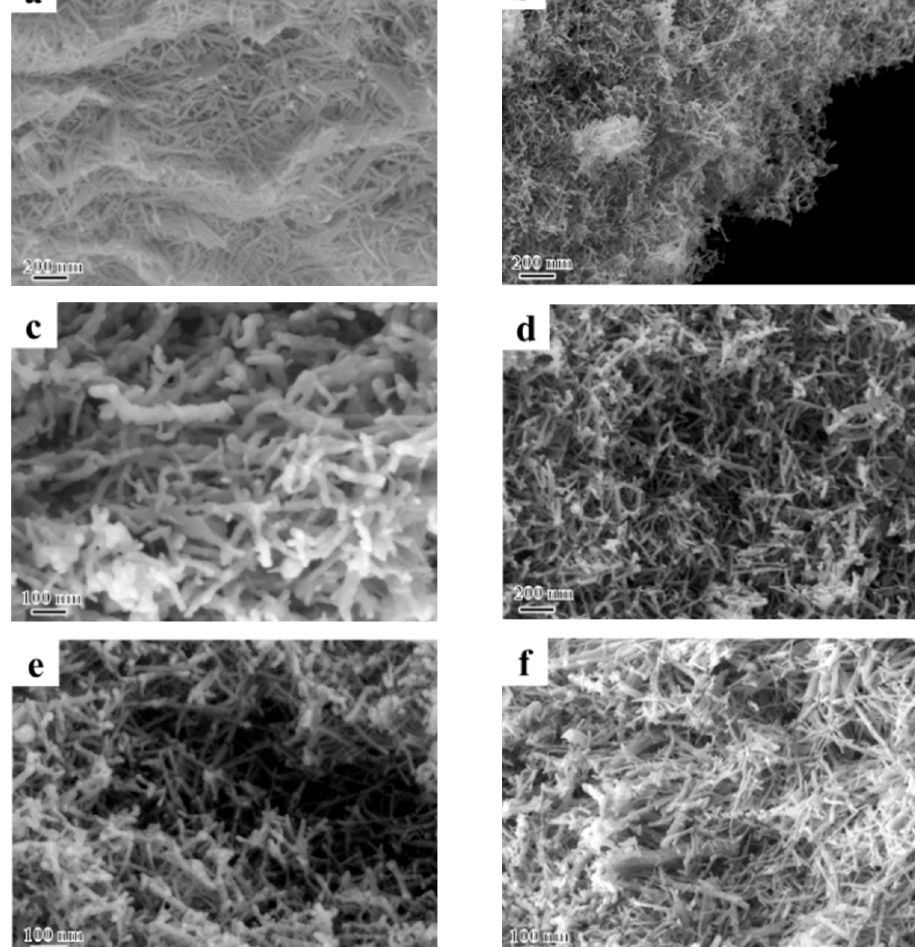
Figure 3. SEM images of the La(OH) 3 , La 2 O 3 and X-La 2 O 3 catalysts. ( a ) La(OH) 3 ; ( b ) La 2 O 3 ; ( c ) Li-La 2 O 3 ; ( d ) Mg-La 2 O 3 ; ( e ) Zn-La 2 O 3 ; ( f ) Ce-La 2 O 3 .